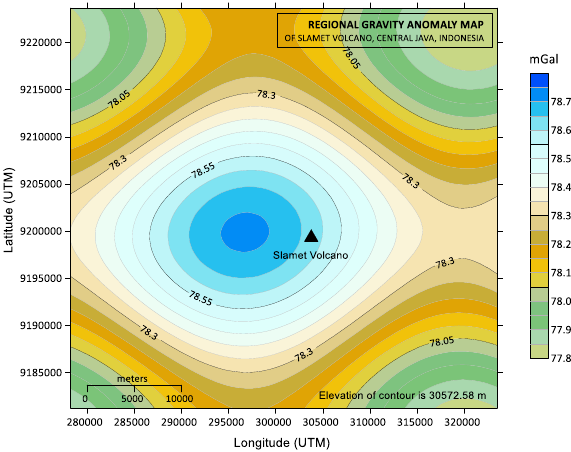
Fig. 7. The regional Bouguer anomalous contour map of study